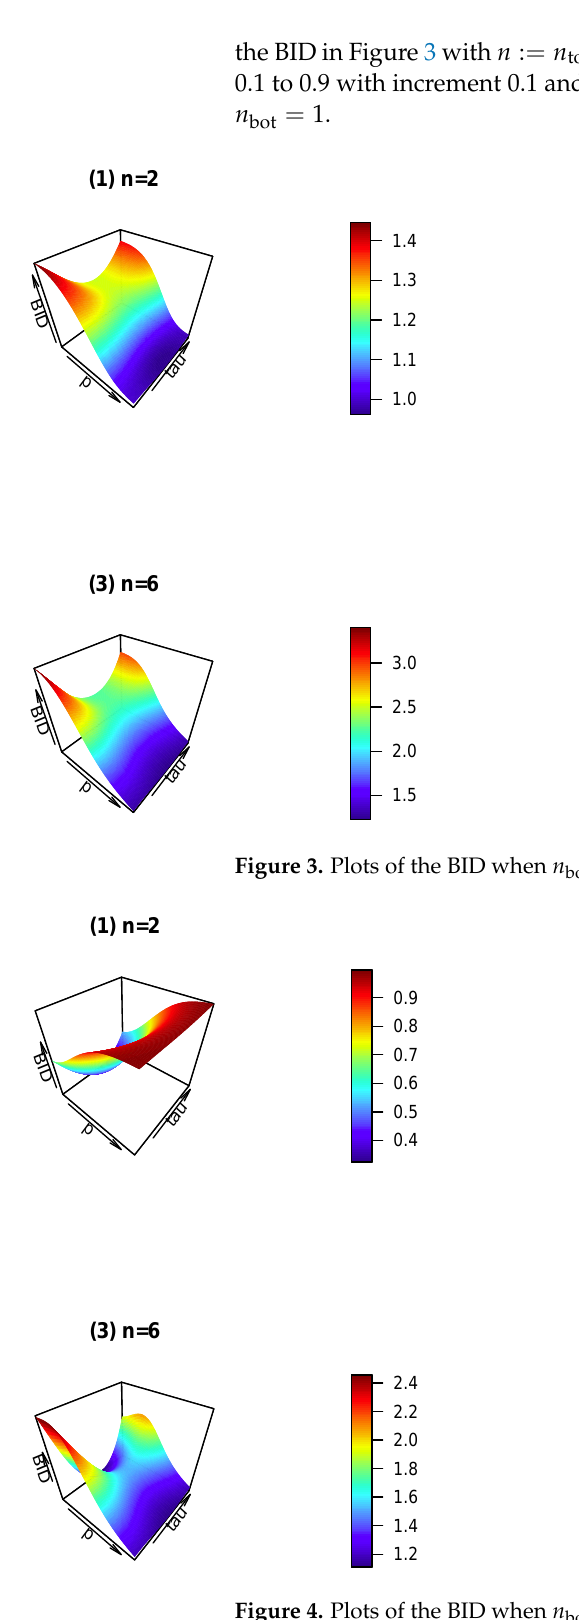
Figure 4. Plots of the BID when n bot =